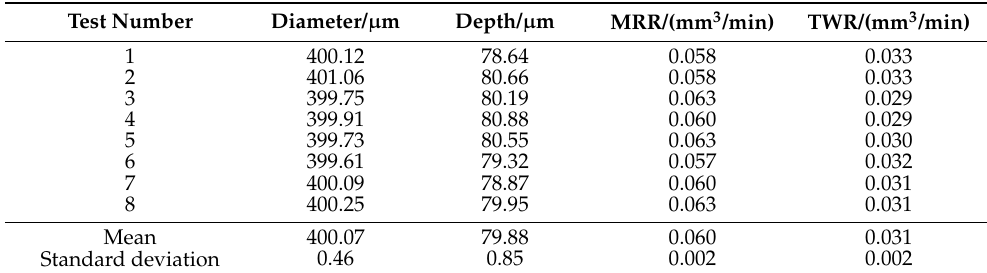
Figure 5. Validation test with repeated pittings on the bearing inner ring. Table 3. Validation test results.